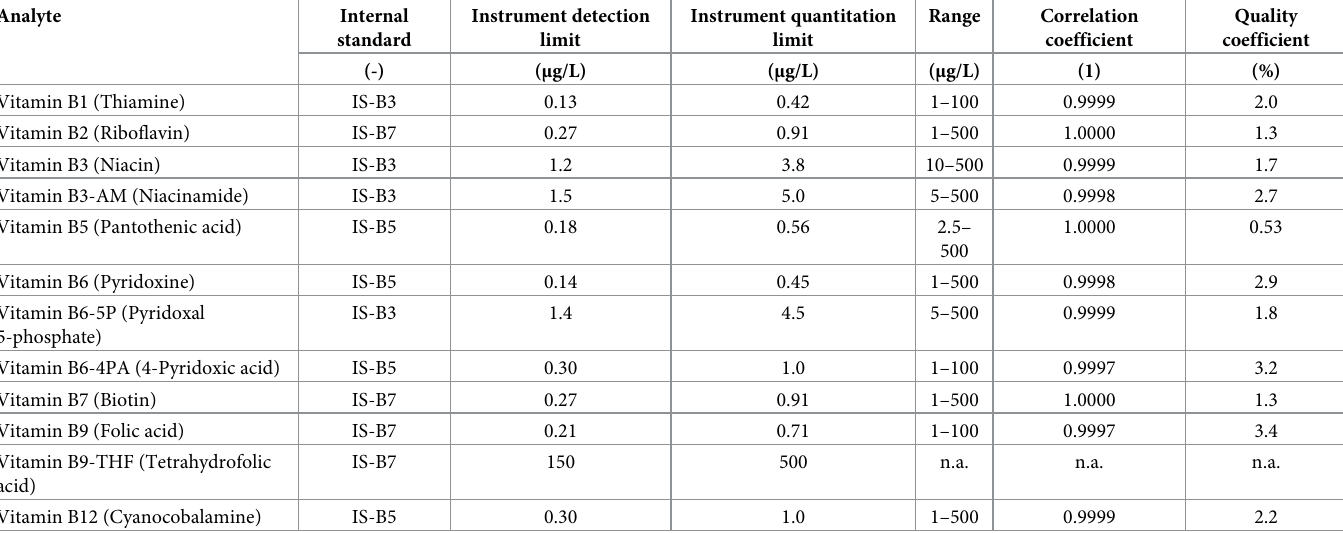
Table 2. Validation characteristics of calibration